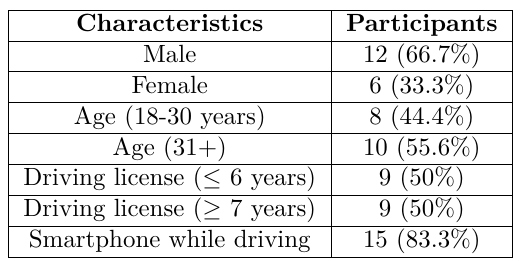
Table 2. Personal characteristics of participants (n =